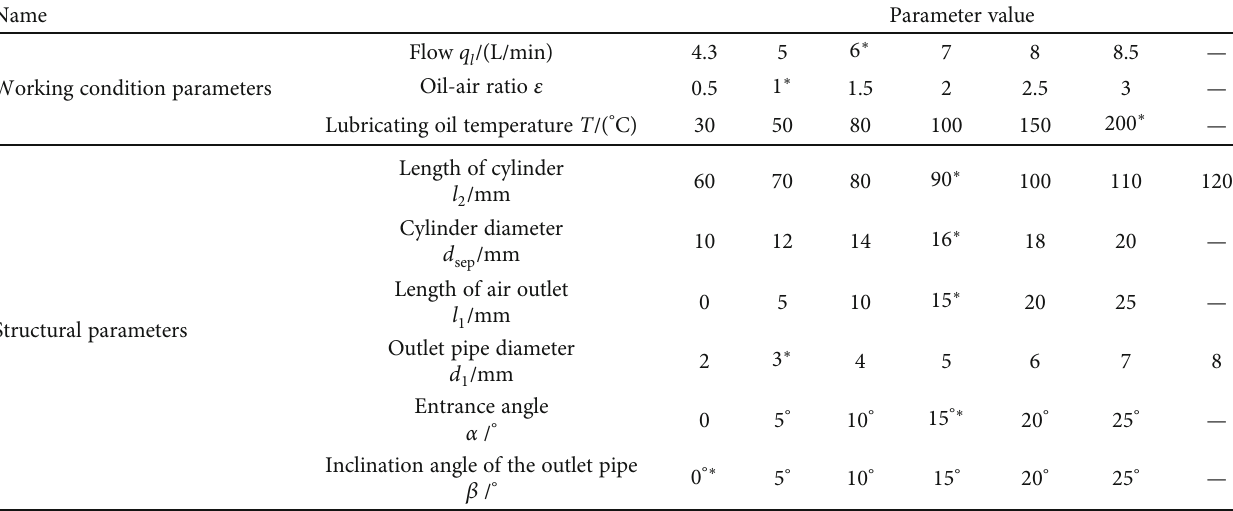
Table 1: Condition and structure parameter values.